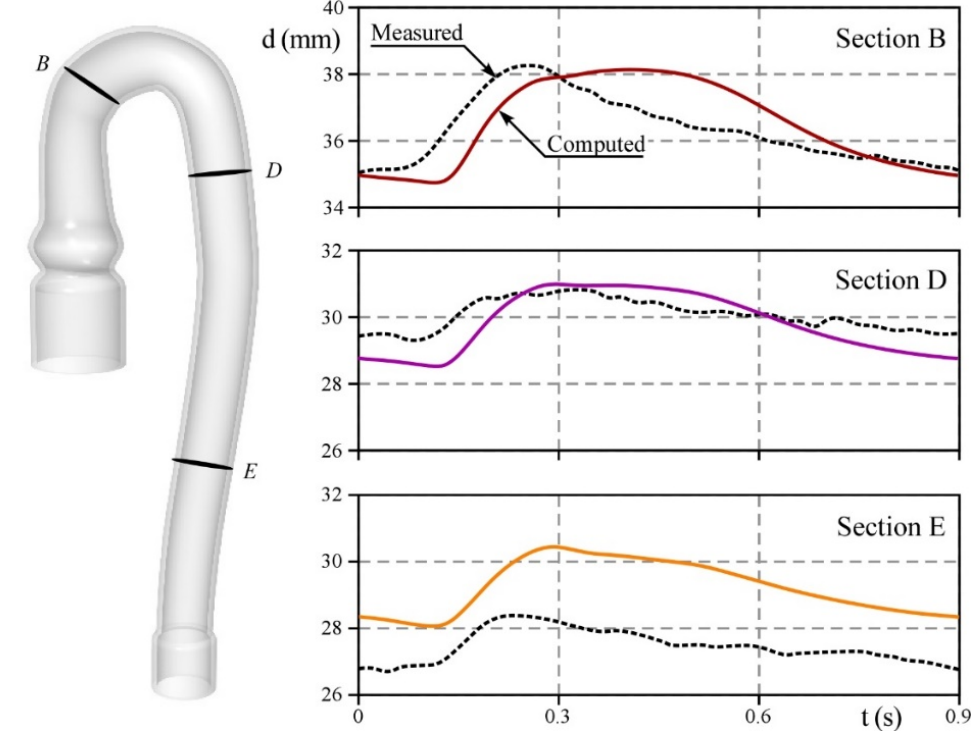
Figure 8. Comparison between the computed (solid lines) and measured (dashed black lines) external diameter in three sections of interest.